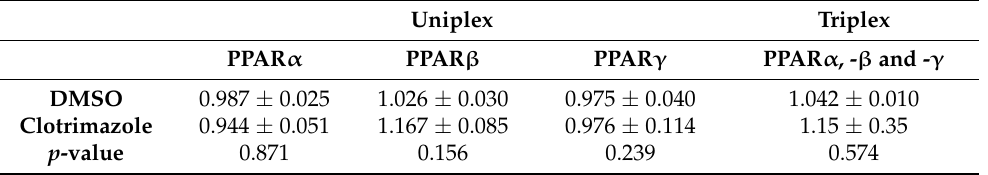
Table 2. Fold induction values observed with the mpFN26A[Fluc]/mpGL4.35[Nluc] sensor system, in uniplex and triplex modes, when exposed to solvent control (DMSO) or to 200 µ M of clotrimazole. Data are shown as mean ± standard error of the mean (SEM) (n = 3). The p value resulted from the statistical analysis (One-Way ANOVA; Tuckey test; p < 0.050), relatively to the solvent control. Dimethyl sulfoxide (DMSO) concentration did not exceed 0.1% per